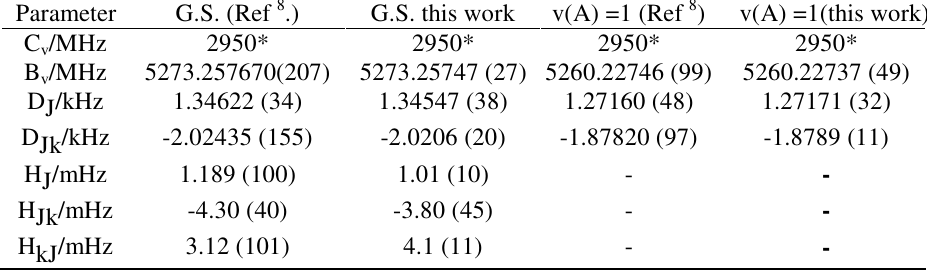
in ground and v(A) = 1